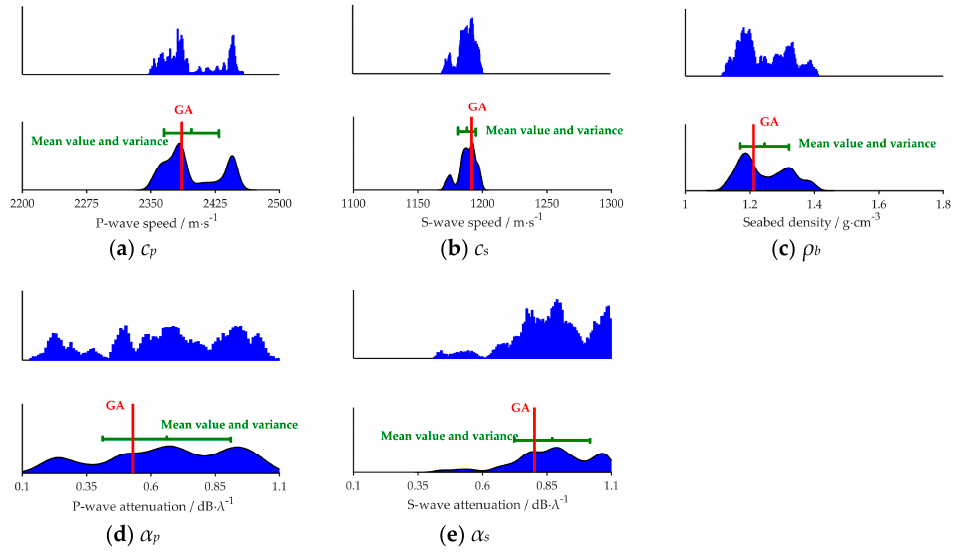
Figure 14. Five geo-acoustic parameters’ PPD. Red lines mean the inversion result of each parameter by GA. Green segments represent the mean value of the inversion results and their variance. Table 4. Inversion parameters: the search bounds and inversion values are shown.